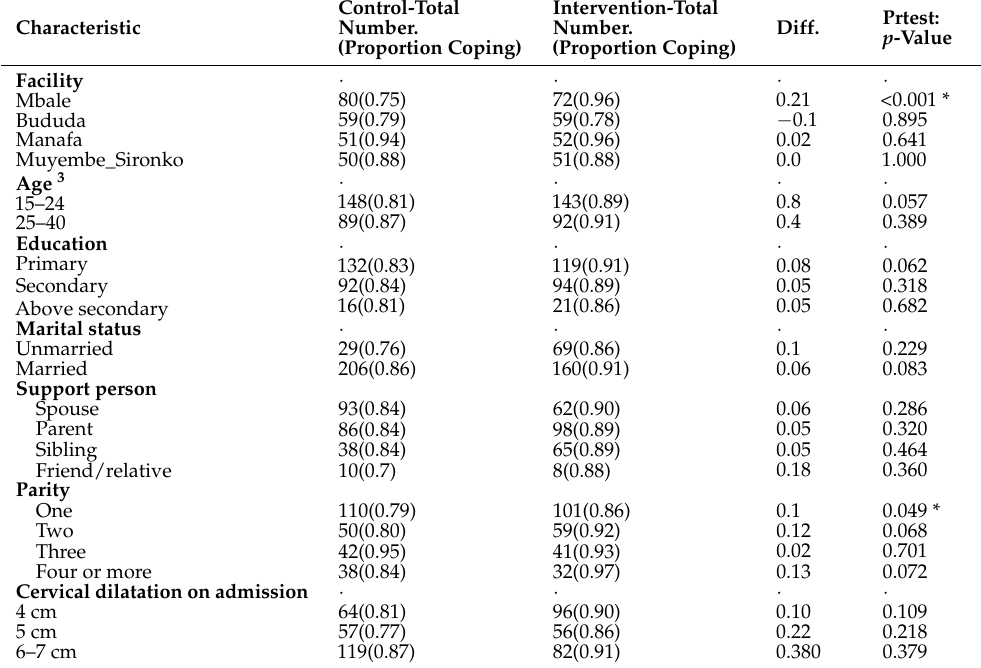
Table 5. Showing treatment effect on coping for specific baseline characteristics. Characteristic